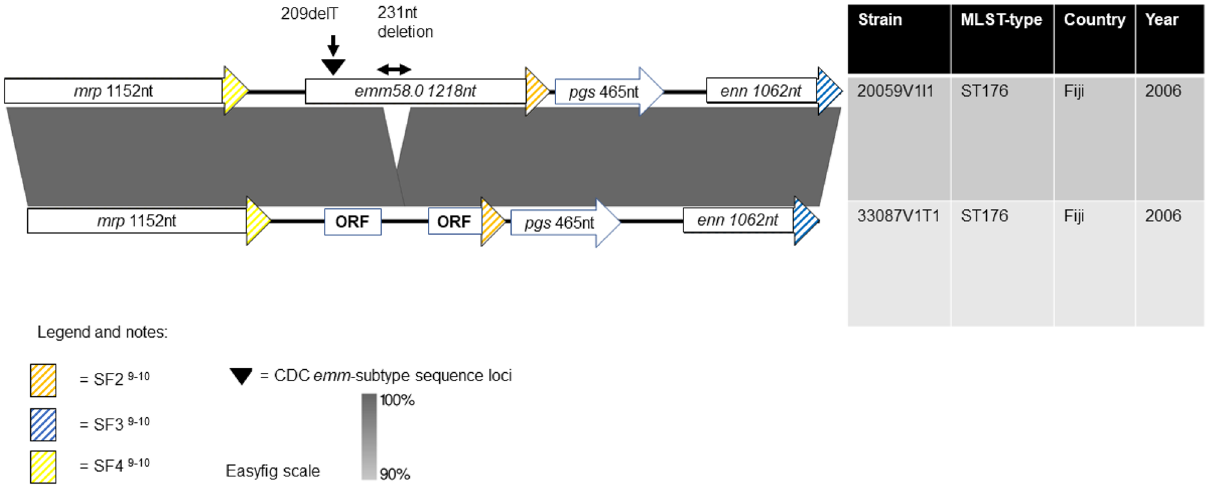
Figure 6. Evolutionary pathway explaining the major disruption to emm of group A Streptococcus 33087V1T1. This also represents a mechanism for the time-dependent excision of the genes of the mga regulon seen in chimeric emm - enn events. It is likely that the nucleotide deletions observed in 20059V1I1 cause disruption that drastically diminishes the function of emm, leading to its eventual deletion.